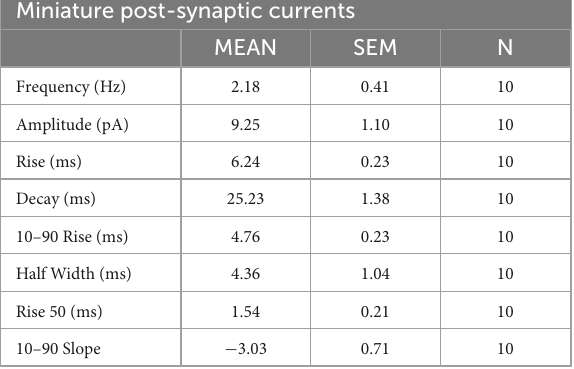
TABLE 2 Summary of miniature post-synaptic currents properties of enteric neurons recorded in whole-cell patch clamp configuration. Miniature post-synaptic